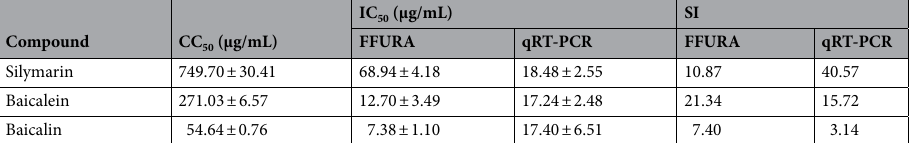
Table 2. The half-maximum inhibitory concentration (IC 50 ) and selective index (SI) of flavonoids against extracellular DENV-3 in virucidal assays. IC50 refers to the 50% inhibitory concentration required to inhibit the virus and was obtained from virucidal assays. SI is a selective index (CC 50 /IC 50 ). FFURA measures the infectious virus particles while qRT-PCR measures the viral RNA copy number. Data were acquired from three independent experiments and presented as mean ± standard error mean (SEM).